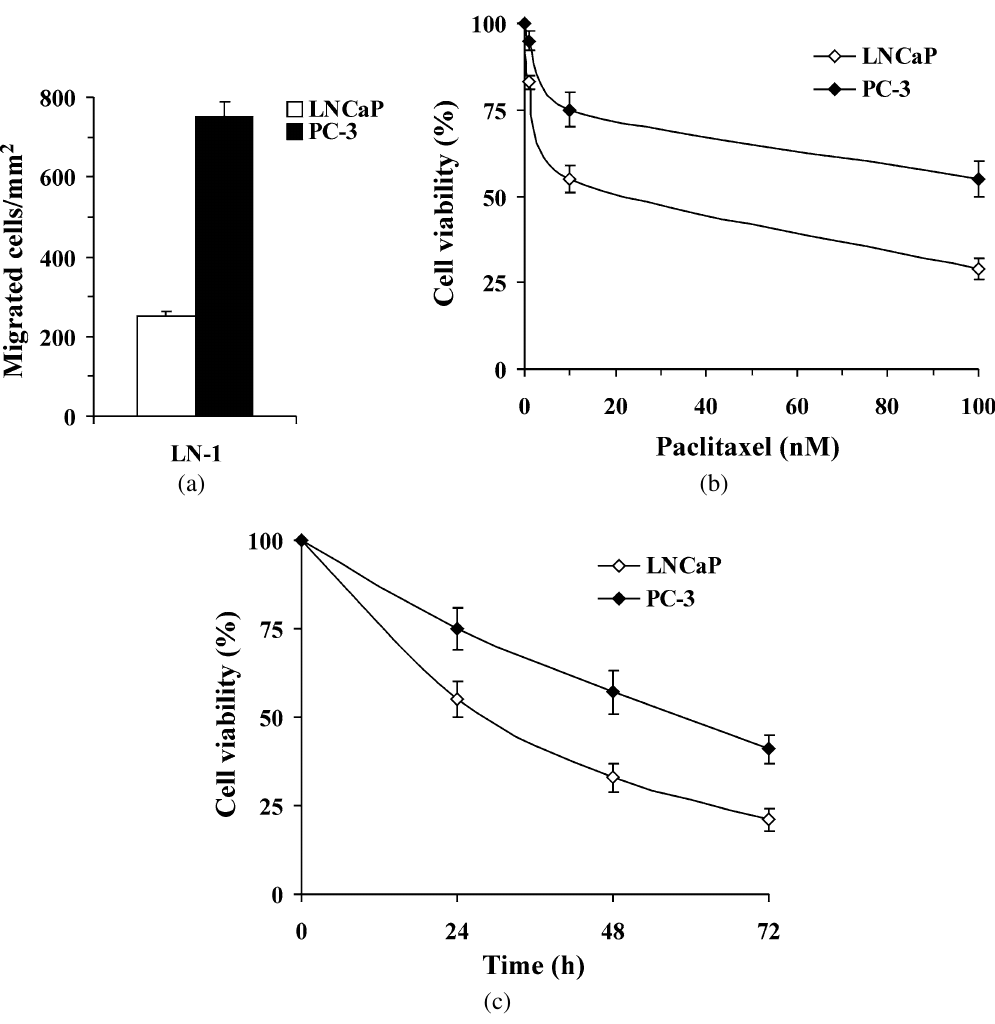
Fig. 2. Migration and chemosensitivity to paclitaxel in LNCaP and PC-3 cells. (a) LNCaP and PC-3 cell migration was assessed by plating 1 . 0 × 10 5 cells onto transwell insert filters coated with 10 µg/ml LN-1. After 12 h, cells on the bottom of the filter were fixed, stained with crystal violet and counted. Measurements represent mean ± S.E. of 10 random fields. A representative experiment of two is shown. (b) Shows the dose-response curves of LNCaP and PC-3 cells after exposure to paclitaxel at three different concentrations (1 nM, 10 nM and 100 nM) for 24 h. Viable cells were measured by MTT assay and expressed as a percentage of the controls. (c) Shows the time-response curves of LNCaP and PC-3 cell lines treated with 10 nM paclitaxel for 24, 48 and 72 h. Data represent mean ± S.E. of three independent